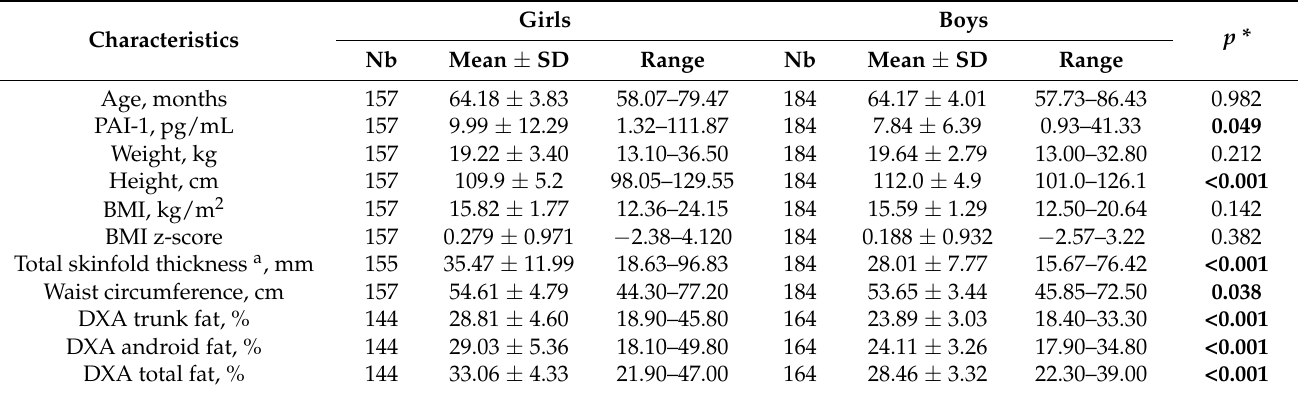
Table 1. Characteristics of Gen3G children included in this analysis, stratified by sex.